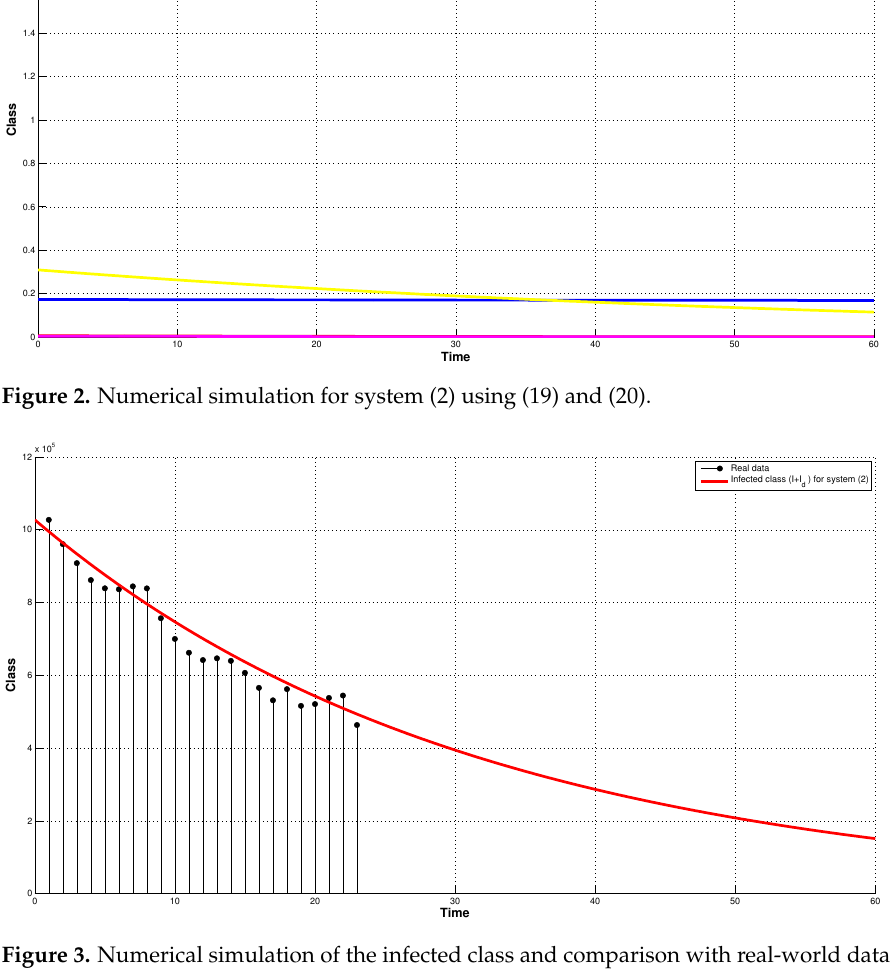
Figure 3. Numerical simulation of the infected class and comparison with real-world